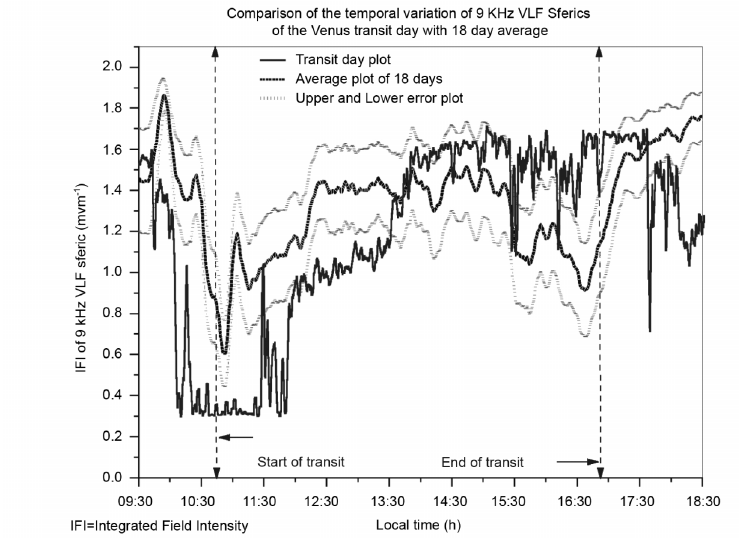
Fig. 2. Variation of atmospheric Integrated Field Intensity (IFI) at 9 kHz VLF on the day of Venus transit, 8th June 2004 (continuous line) and average variation of the same parameter around 8th June for 18 days (dotted line) and the dotted grey lines represent standard deviation.